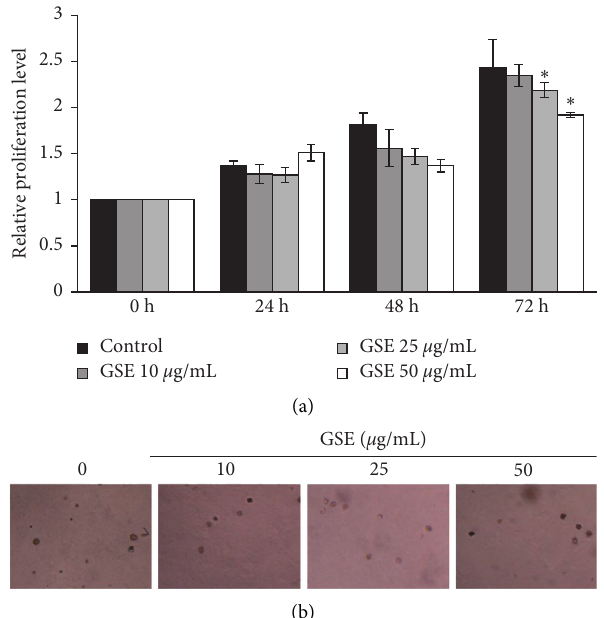
Figure 2: Cell proliferation of MCF-7 cells after exposure to GSE. (a) MCF-7 cells were treated with GSE at 0–50 μ g/mL for 72h, and cell viability was investigated by MTT assay. The relative cell proliferation at 24, 48, and 72h was calculated compared to time 0. (b) Colony formation was determined by microscopy (4 × ) after 14 days of GSE treatment. Data represent the mean ± SD ( n � 3). ∗ Significantly different at p < 0 . 05 versus nontreated